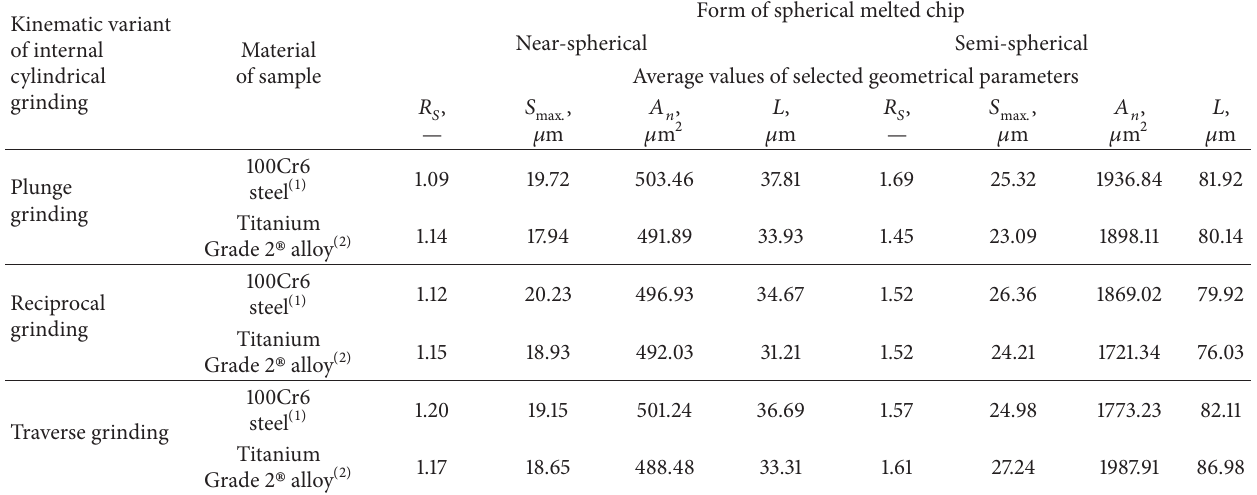
Table 6: Average values of selected geometrical parameters calculated for two forms of spherical melted chips formed during internal cylindrical grinding process carried out in three kinematic